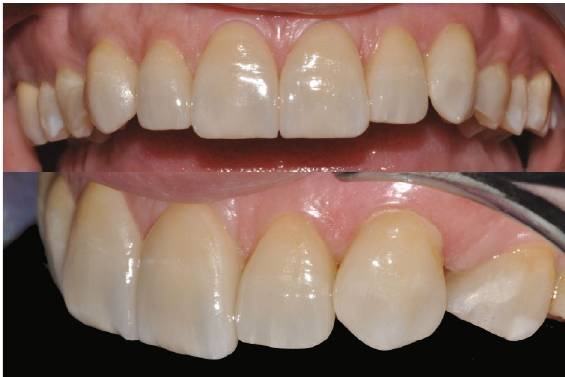
Figure 9: Final result with 3-year